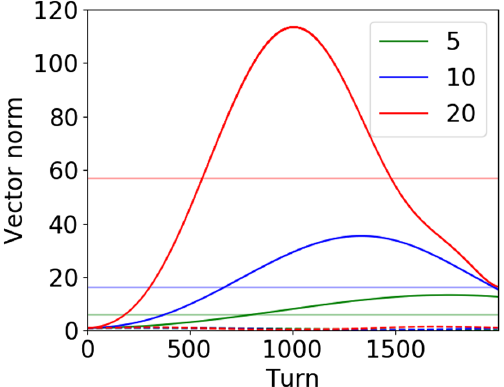
FIG. 12. Evolution of the norm of a vector associated with two different initial perturbations under multiplications by the one turn matrix M . The one turn matrix corresponds to a normalized intensity of 20, the space charge tune shift is 5, 10 and 20 for the green, blue and red curves respectively. The airbag model was considered with 100 slices. The solid and dashed lines correspond to two different initial perturbations, corresponding to a dis- placement of the head and tail of the bunch respectively. The shaded curves show the Kreiss constant associated with the corresponding one turn